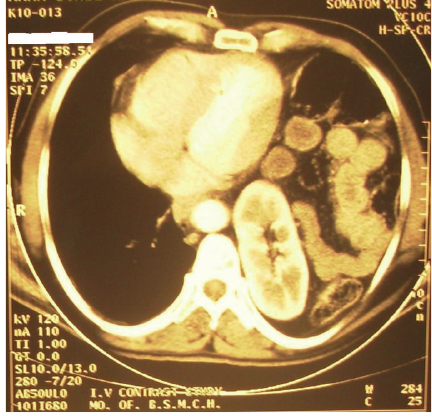
Figure 3: Computed tomography scan of thorax showing presence of bowel loops and kidney in the left